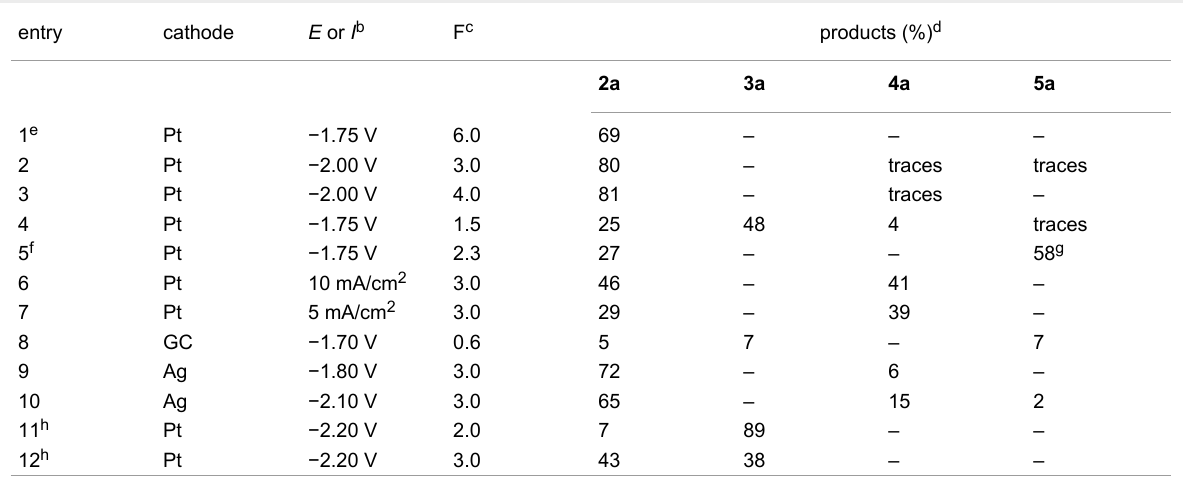
Table 1: Electrochemical synthesis of 2-ethynylnaphthalene ( 2a ). Electrolysis conditions optimization (Scheme 5).